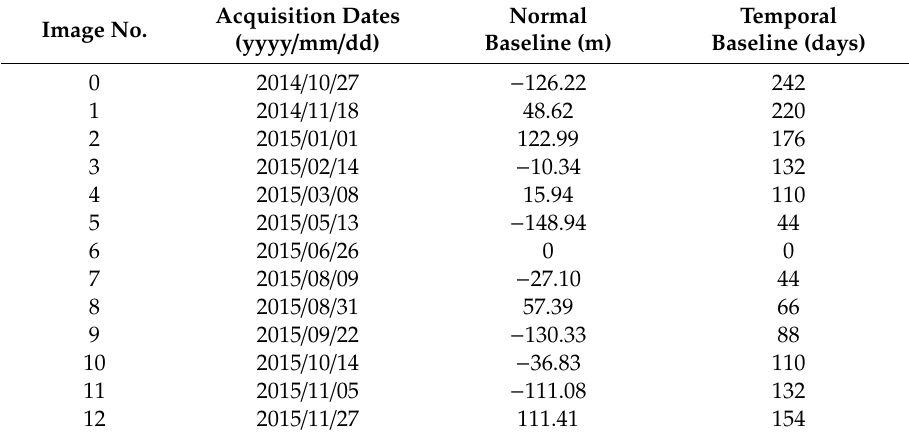
Table 1. List of the interferometric pairs and their parameters with image number 6 as the master (orbit no.119).